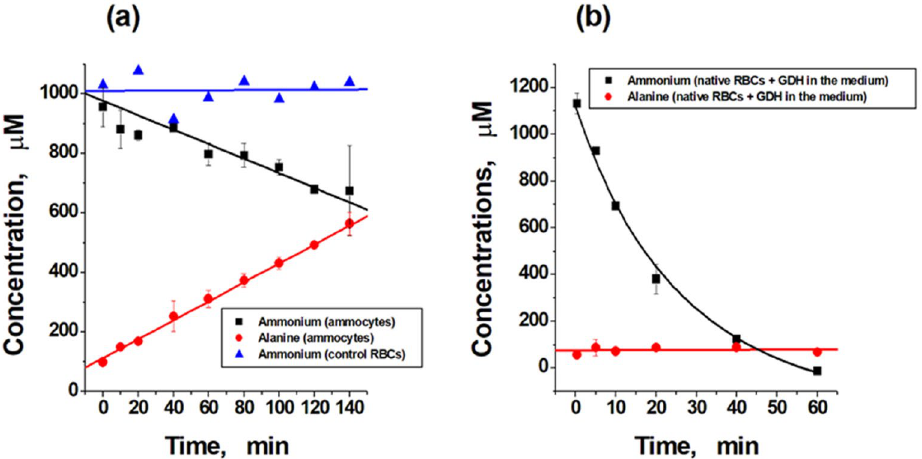
Figure 3. Typical kinetics of ammonium consumption and alanine production in the presence of ammocytes or free enzymes in vitro. Measurements were carried out in the presence of ammocytes from one of the donors (suspension hematocrit 23%, temperature 25 °C, and 1 mM of added NH 4 Cl). ( a ) Kinetics of ammonium consumption (black line) and alanine formation (red line) in the presence of ammocytes (activities of GDH and ALT in the suspension are equal to 0.57 IU/ml and 6.7 IU/ml, respectively), as well as the concentration of ammonium in the control in the presence of native cells (blue line). ( b ) Kinetics of ammonium and alanine concentrations in the presence of native RBCs and added to the external medium GDH (0.2 IU/ml of solution). Mean values ± SD are presented, n =